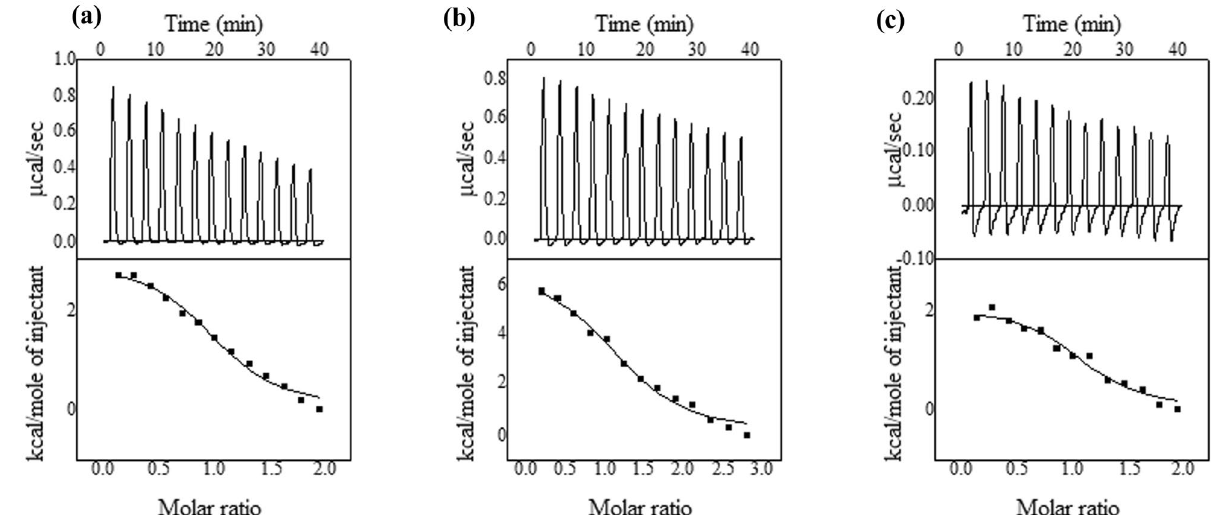
Figure 3. ITC data of titration of PIMT with ( a ) AuNS5, ( b ) AuNS50 and ( c ) AuNS100 using 20 mM of sodium phosphate buffer (pH 7.2) at 25 °C. The top panel shows the heat flow versus time for each injection of AuNSs while the bottom panel shows the heat evolved per mole of added ligands.